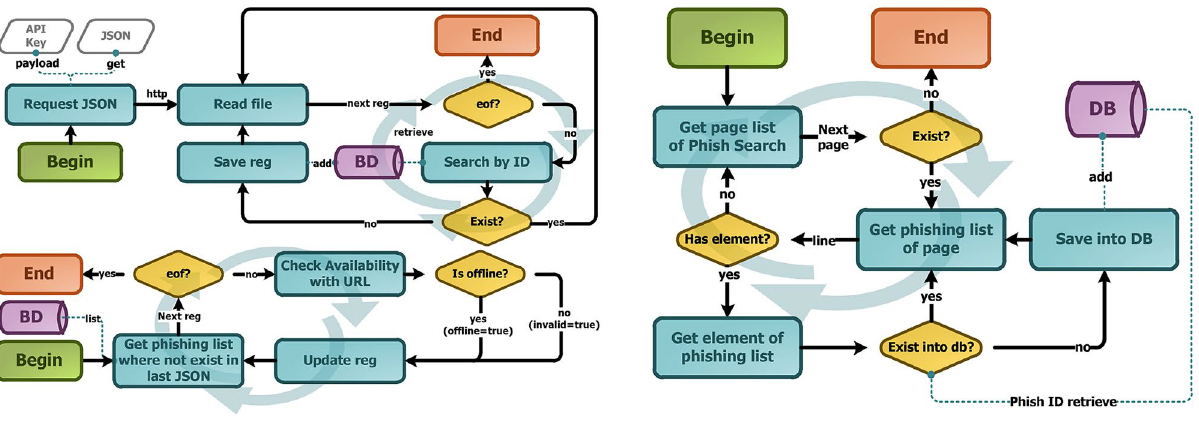
Figure 3. Extraction process